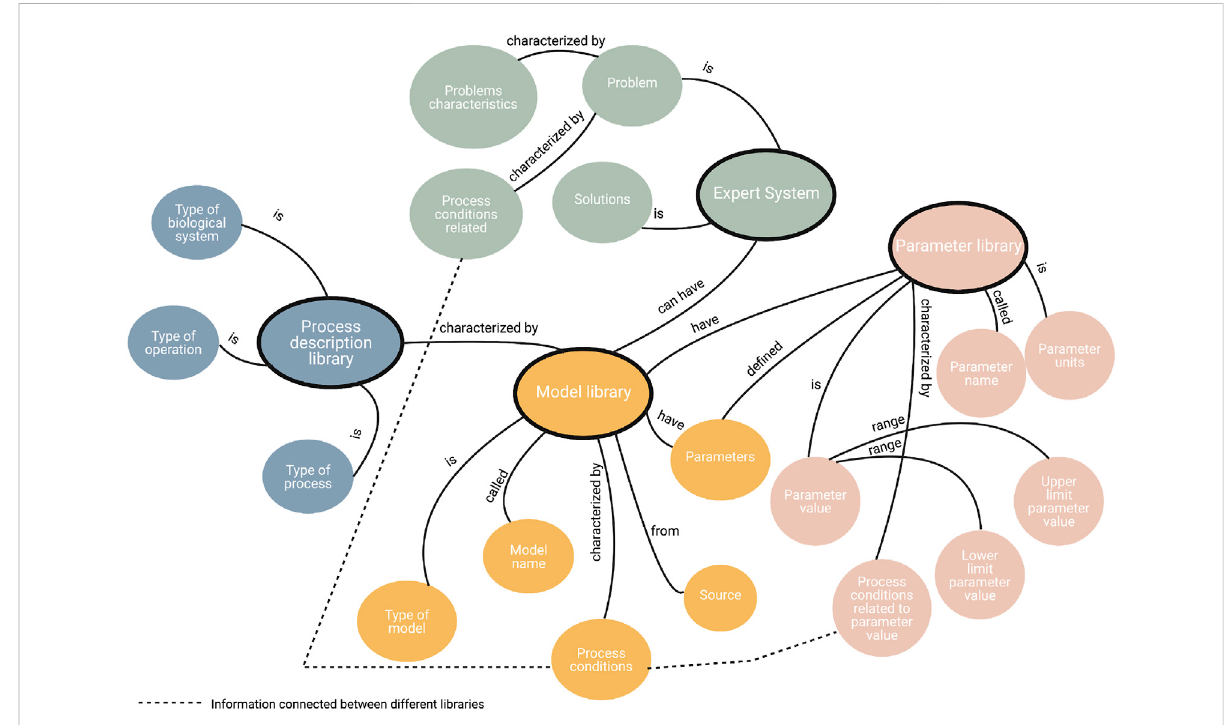
FIGURE 5 NyctiDB ’ sUML-linkedknowledge graph. Althoughincluded inthisgraph, theaxioms donothave great relevanceduring theimplementationof the ontology inside the database. The axioms are depicted for the sake of clarity and interpretability of the functional dependencies.